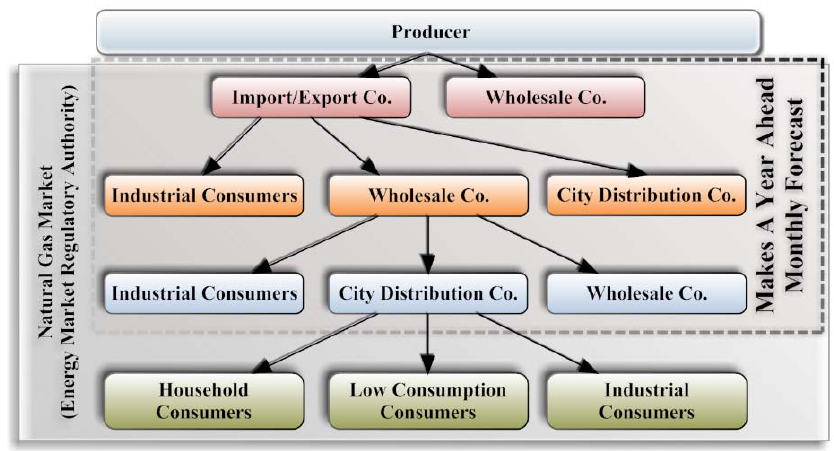
Figure 1. Turkey natural gas market and users.